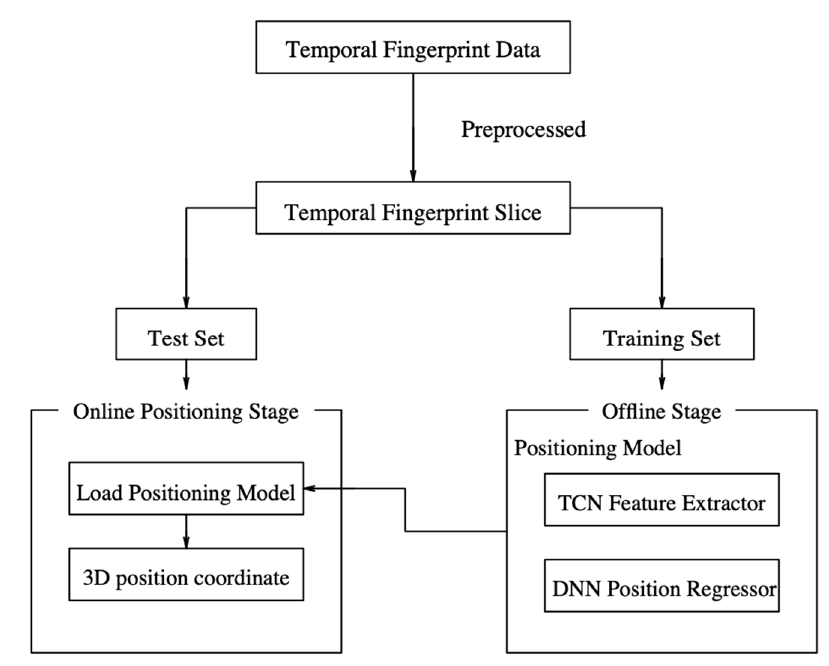
Figure 2. TCN_DNNLoc framework.